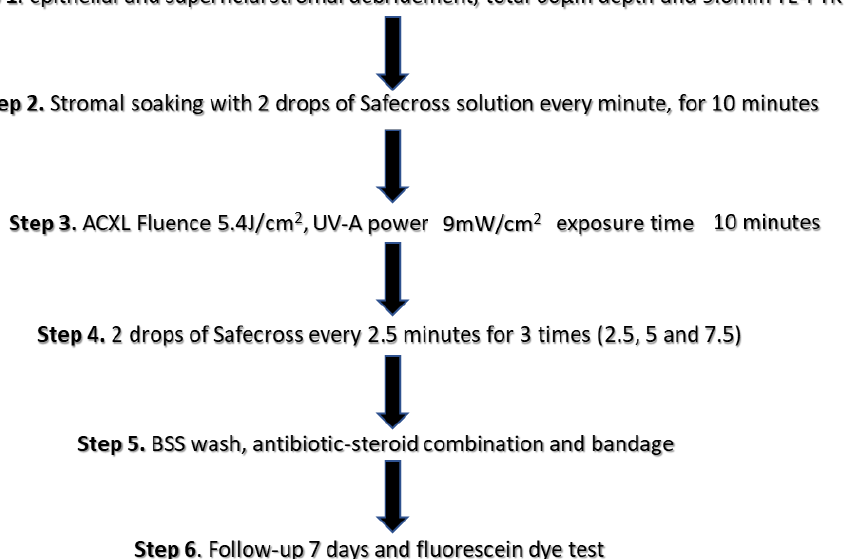
Chart 1. The flow chart of the preclinical study on New Zealand Rabbits. Legend. ACXL: Acceler- ated cross-linking; UV-A: Ultraviolet-A; BSS: Balanced saline solution; TE-PTK- Trans-Epithelial Photo-Therapeutic Keratectomy. Corneas remained transparent throughout the healing process in the SafeCross ® - treated eyes (Figure 1a), while eyes treated with riboflavin + 0.10% EDTA showed a grade 2 to 3 haze in 55% of the cases (Figure 1b).